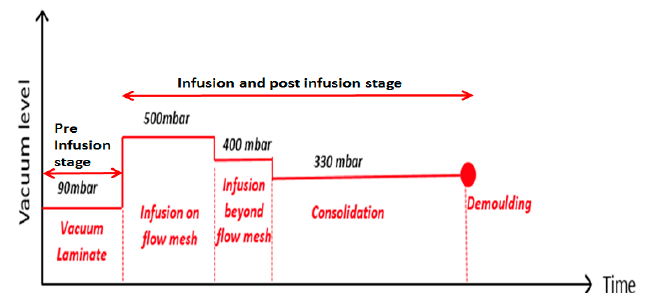
Figure 12. Optimised Three Stage vacuum levels deduced from VARI process and NCF composite quality optimisation.